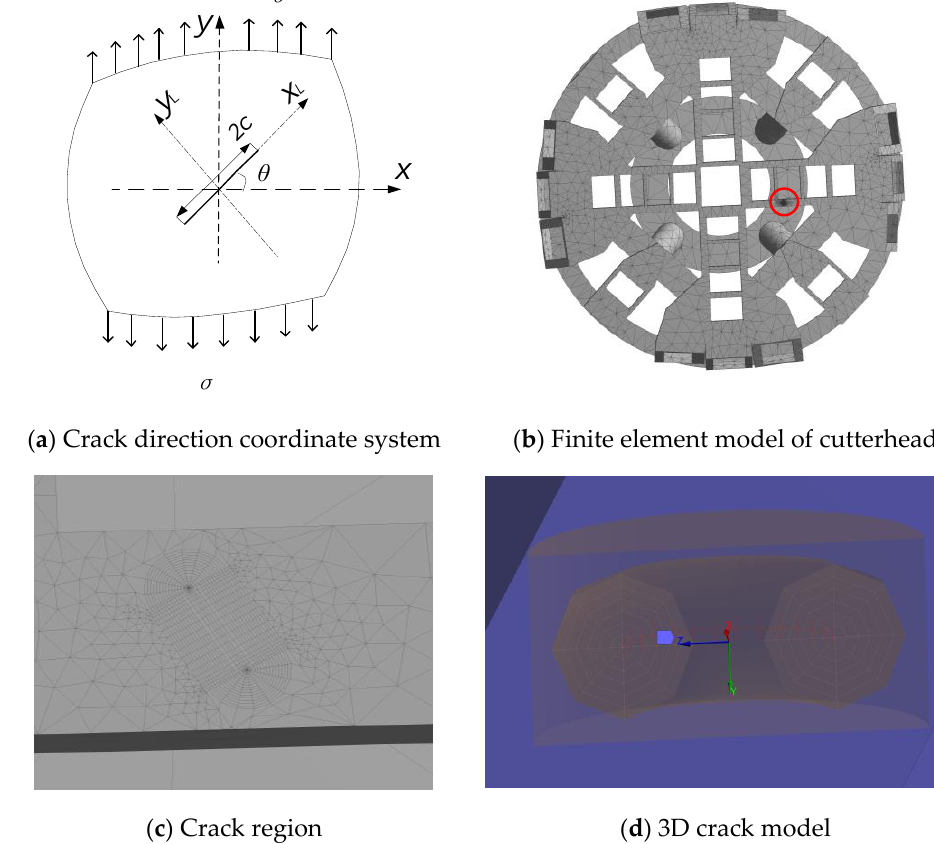
Figure 6. Definition of crack position angle: ( a ) Crack direction coordinate system ( b ) Finite element model of the cutterhead ( c ) Crack region ( d ) 3D crack model.